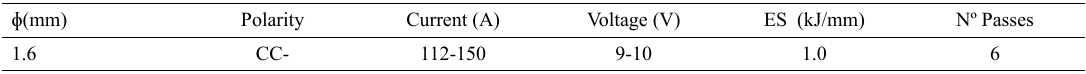
Table 3: Welding parameters and average welding